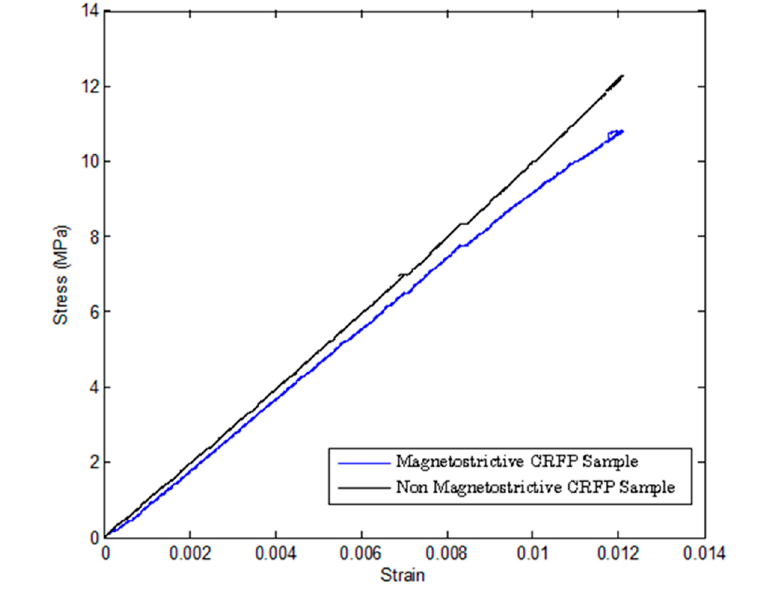
Figure 3. Stress-Strain Curve. Elastic modulus of the Non Magnetostrictive and Magnetostrictive CFRP sample.